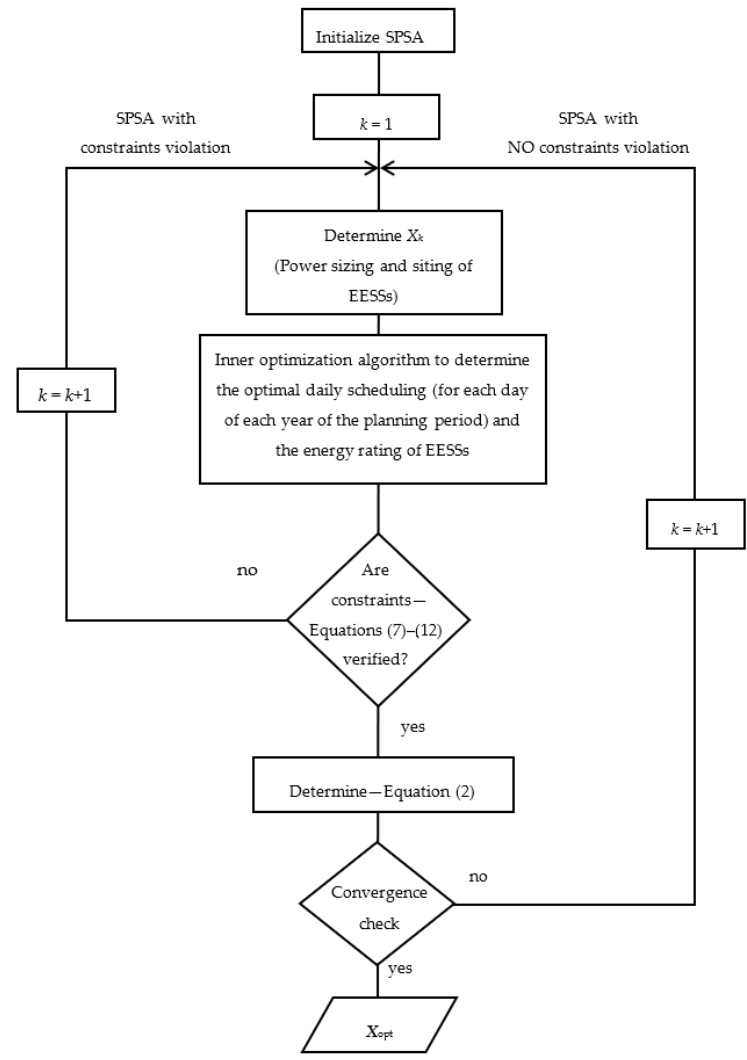
Figure 1. Flow chart of the solving procedure.